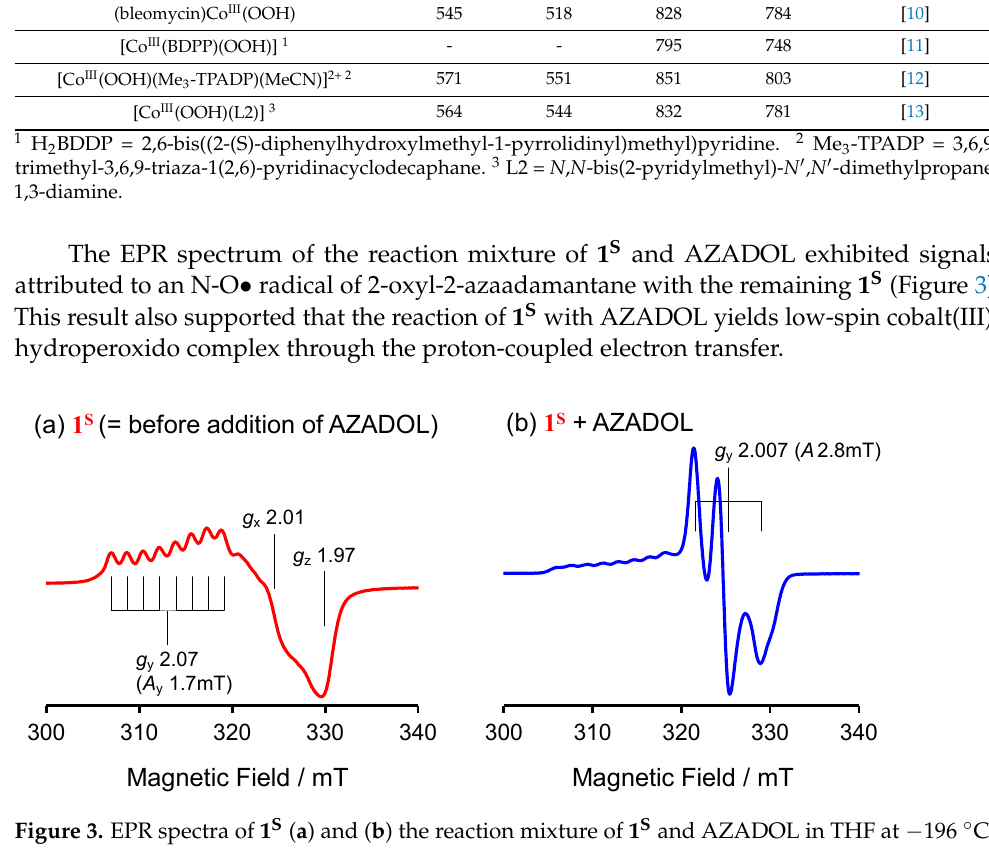
Figure 3. EPR spectra of 1 S ( a ) and ( b ) the reaction mixture of 1 S and AZADOL in THF at − 196 °C. The kinetics of the reaction of 1 S with the excess amount of AZADOL was examined by monitoring the increase of the absorption at 300 nm. The reaction followed pseudo-first-order kinetics. The kinetic isotope effect (KIE; k H / k D = 9.4) was observed in the reaction of 1 S with the O-D group-containing AZADOL (AZADOL- d 1 ), as shown in Figure 4. This result indicated the O-H bond cleavage of AZADOL was involved as the rate-determining step in the formation of the cobalt(III)-hydroperoxido complex 1 H .